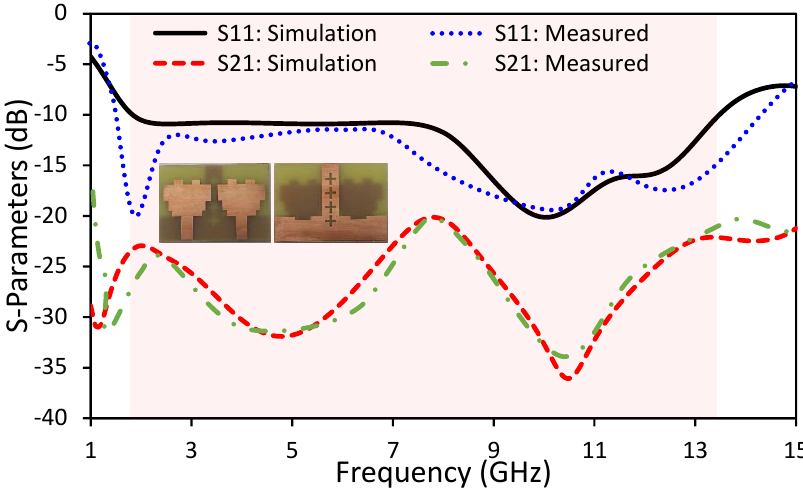
Figure 8. Simulated and measured S-parameters of the